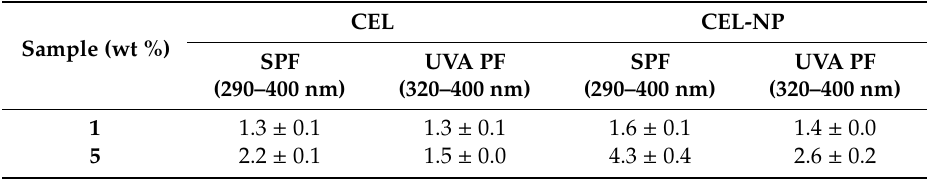
Figure 5. UV transmittances of the creams blended with ( a ) 1 and ( b ) 5 wt % CEL and CEL-NP. Table 3. SPF (sun protection factor) and UVA PF (protection factor) of the moisturizing cream * blended with different amounts of CEL and CEL-NP.